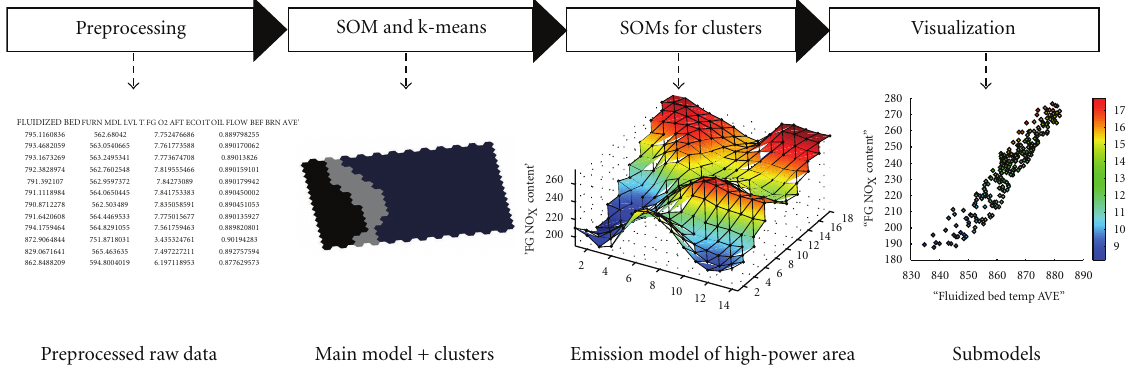
Figure 2: Data analysis stages and their